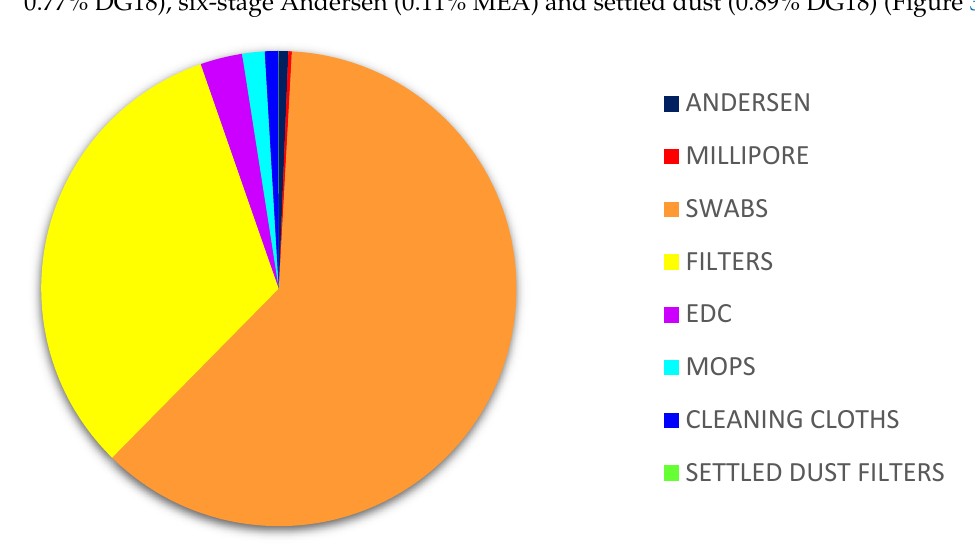
Sample section (100%). Similar results were obtained in swabs samples from FFH3, Aspergillus being the most frequent genera (0.08%) and Fumigati being the prevalent section (100%). Andersen Regarding samples collected from all FFHs, the genus Aspergillus was present in almost all matrices, with a prevalence of 1.52% in MEA (Millipore; six-stage Andersen; EDCs; cleaning cloths; mops; settled dust filters; swabs) and 2.20% in DG18 (Millipore; Millipore Aspergillus sp. six-stage Andersen; EDCs; cleaning cloths; settled dust filters; swabs), being absent in mops, identification badges and settled dust samples in MEA and identification badges in DG18 (Table 3). Table 3. Aspergillus sp. distribution in all matrices in MEA and DG18 from all FFHs. Sample